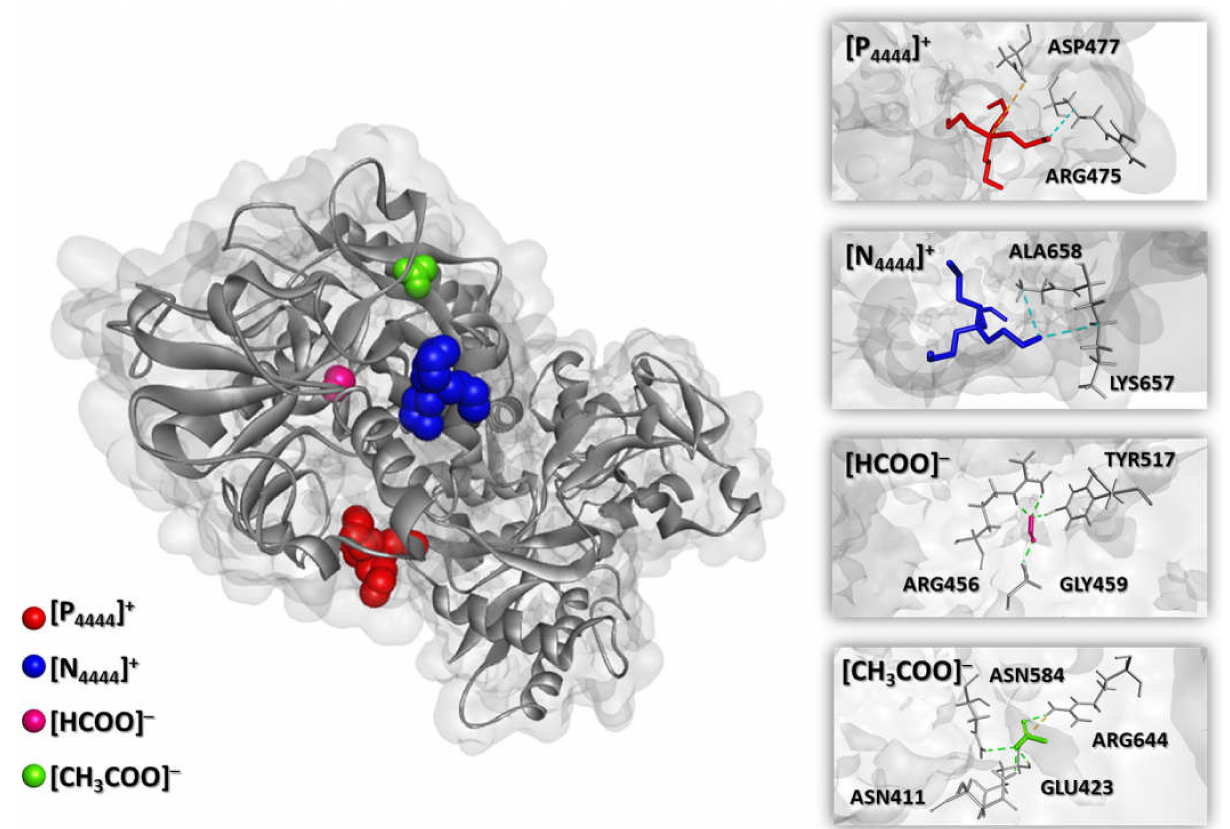
Figure 5. Docking pose with the lowest absolute value of affinity (kcal · mol − 1 ) and interacting amino acids for transferrin (pH